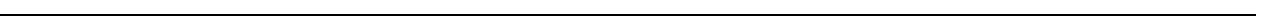
Fig. 5 Selection of resistance mutations generated using the AsCpf1 endonuclease. a An overview of AsCpf1 crRNAs targeting XPO1 , KIF11 , and ERCC3 at their resistance hotspot residues. The AsCpf1 cleavage site, generating a four nucleotide overhang, is denoted by red arrowheads. b Cell viability of wild- type and polyclonal mutagenized resistant cells in the presence of increasing concentration of drug. Values are shown relative to untreated controls. Data points represent mean ± s.d. obtained from two experiments performed in triplicate. c Amino-acid sequence variants determined by targeted amplicon- sequencing analysis of the resistant cells with CrispRVariants. Only variants with a frequency ≥ 1% are shown. d An overview of the CRISPR-AsCpf1 tiling crRNA library approach used for target identi fi cation of selinexor. A lentiviral tilling library targeting 10 different genes was constructed and transduced in cells stably expressing AsCpf1, which were fi rst selected with puromycin and subsequently treated with selinexor (2 µ M). crRNAs present in resistant colonies were identi fi ed by next-generation sequencing after which the genomic locus targeted by these crRNAs was sequenced to identify the resistance conferring mutations in the target gene. e Cell viability in the presence of different concentrations of selinexor of wild-type and resistant cells obtained after library transduction and selinexor treatment. Three experiments were performed in triplicate. Data points represent mean ± s.d. f Representation of the different crRNAs present in the cells before (after puromycin selection) and after treatment with selinexor as determined by EdgeR analysis of next- generation sequencing data. A value of 1 was added to each read count to facilitate log transformation. Each dot represents a different crRNA. g crRNA hits enriched over 100-fold in the selinexor-resistant cell pool after AsCpf1-mediated mutagenesis screen. Read counts were determined using EdgeR. h Amino- acid variants detected in the XPO1 C528 locus of the resistant cells. Alterations were uncovered by CrispRVariants analysis of next-generation